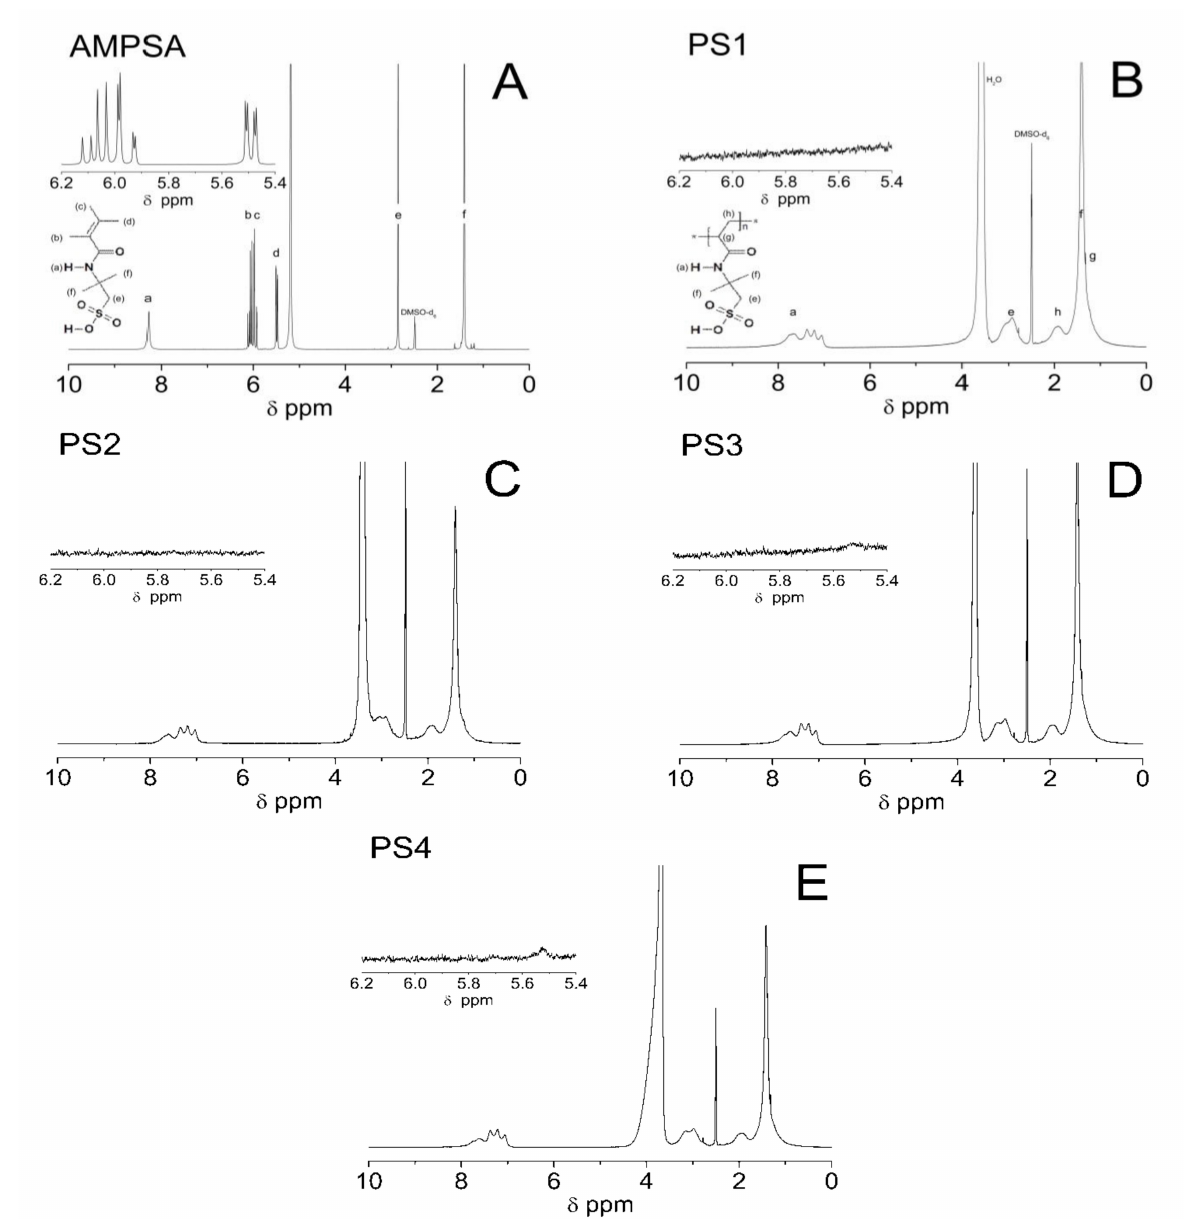
Figure 7. ( A – E ) H nuclear magnetic resonance ( 1 H NMR) spectra of monomer AMPSA ( A ) and synthesized polymers PS1 ( B ); PS2 ( C ); PS3 ( D ); and PS4 ( E ) recorded in deuterated dimethyl sulfoxide (DMSO-d 6 ). The expanded areas in the 1 H NMR spectra present the resonance range of the vinyl